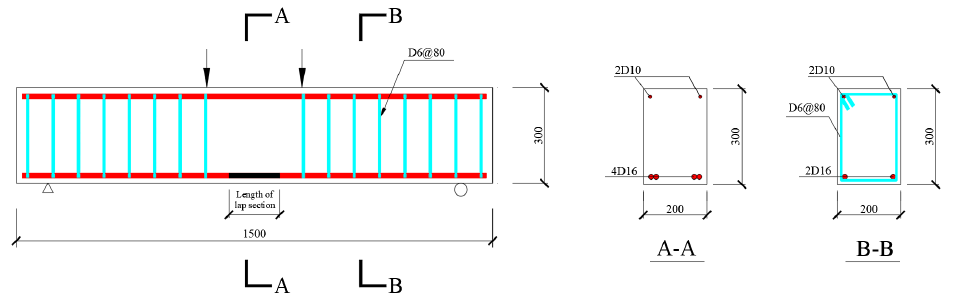
Figure 1. Loading scheme (unit: mm).